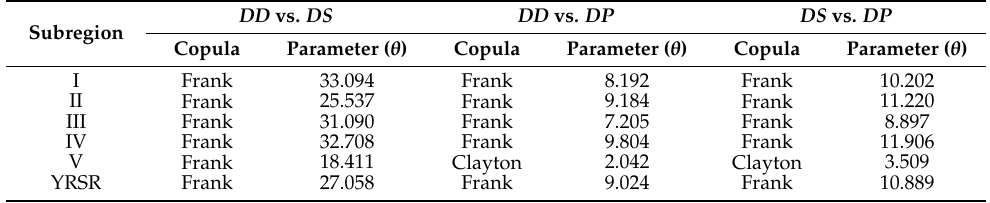
Table 2. The estimated parameters of the best-fitted copulas for subregions I–V and entire